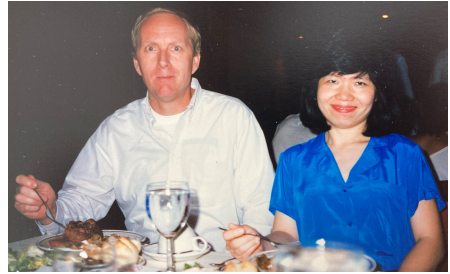
Figure 5: Ron Graham and Fan Chung.